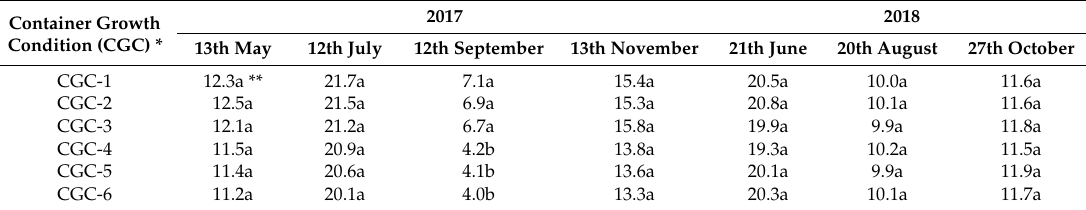
Table 3. Moisture contents (%) a ff ected by container growth conditions.